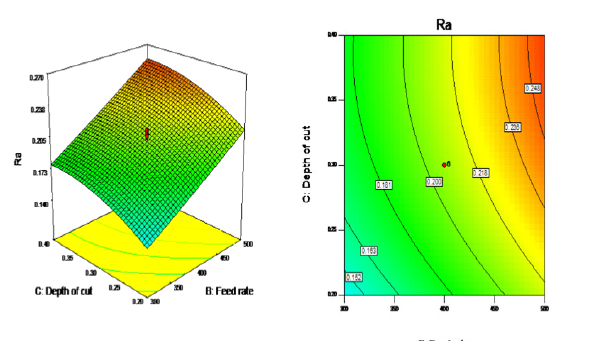
Fig. 7: 3D Response and Contour Plot of Surface Roughness Vs Cutting Speed and Depth of Cut